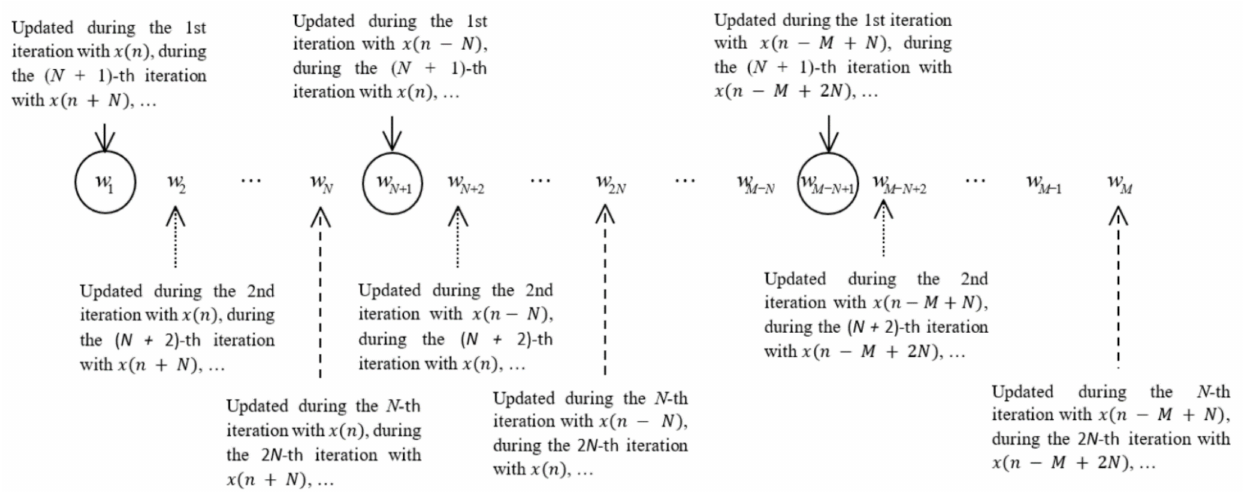
Figure 1. Scheme of the Seq. PU adaptive algorithm; here, we point out the coefficients to be updated at every cycle as well as the related samples of the regressor